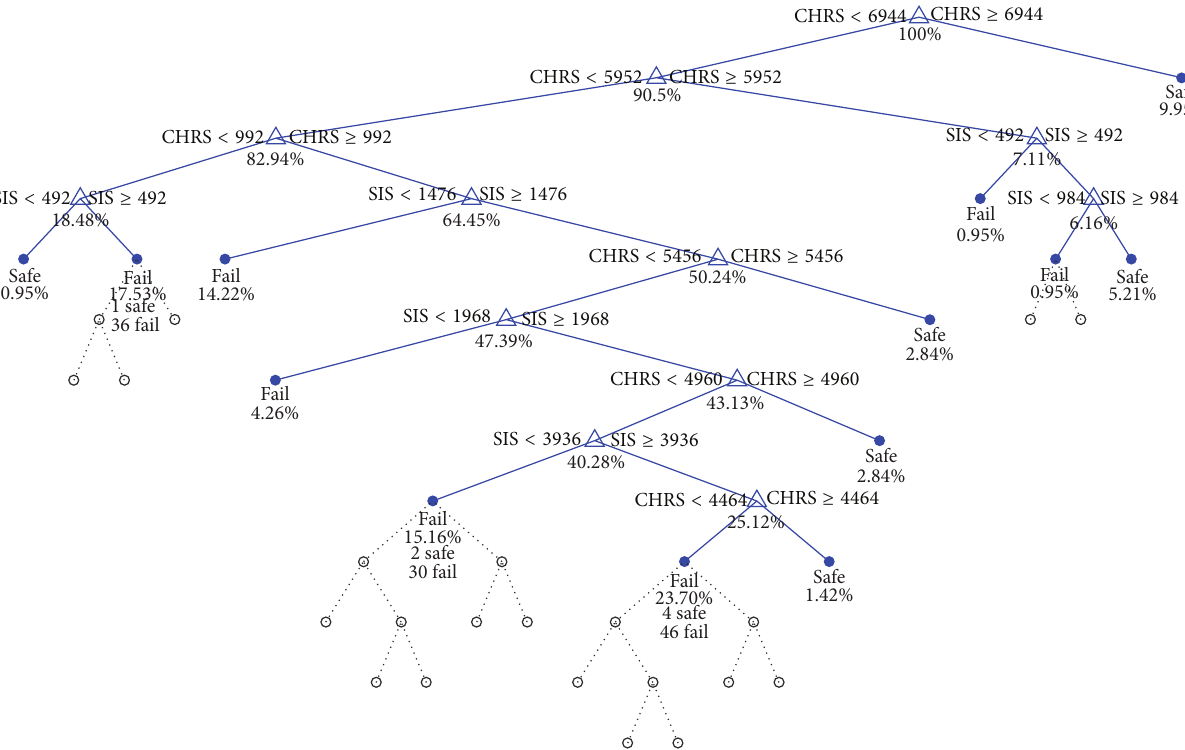
decision tree. Decision trees (Figures 10 and 11) are built with data set in both original coordinate system and coordinate system defined by its principal components (Figures 5 and